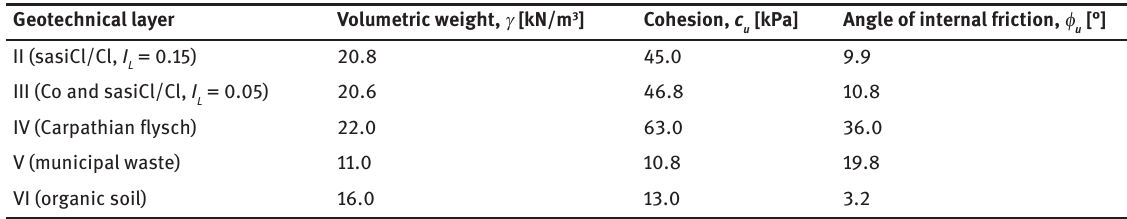
Table 3 : Parameters of the geotechnical layers used in the stability calculations [26, 27]. Geotechnical layer